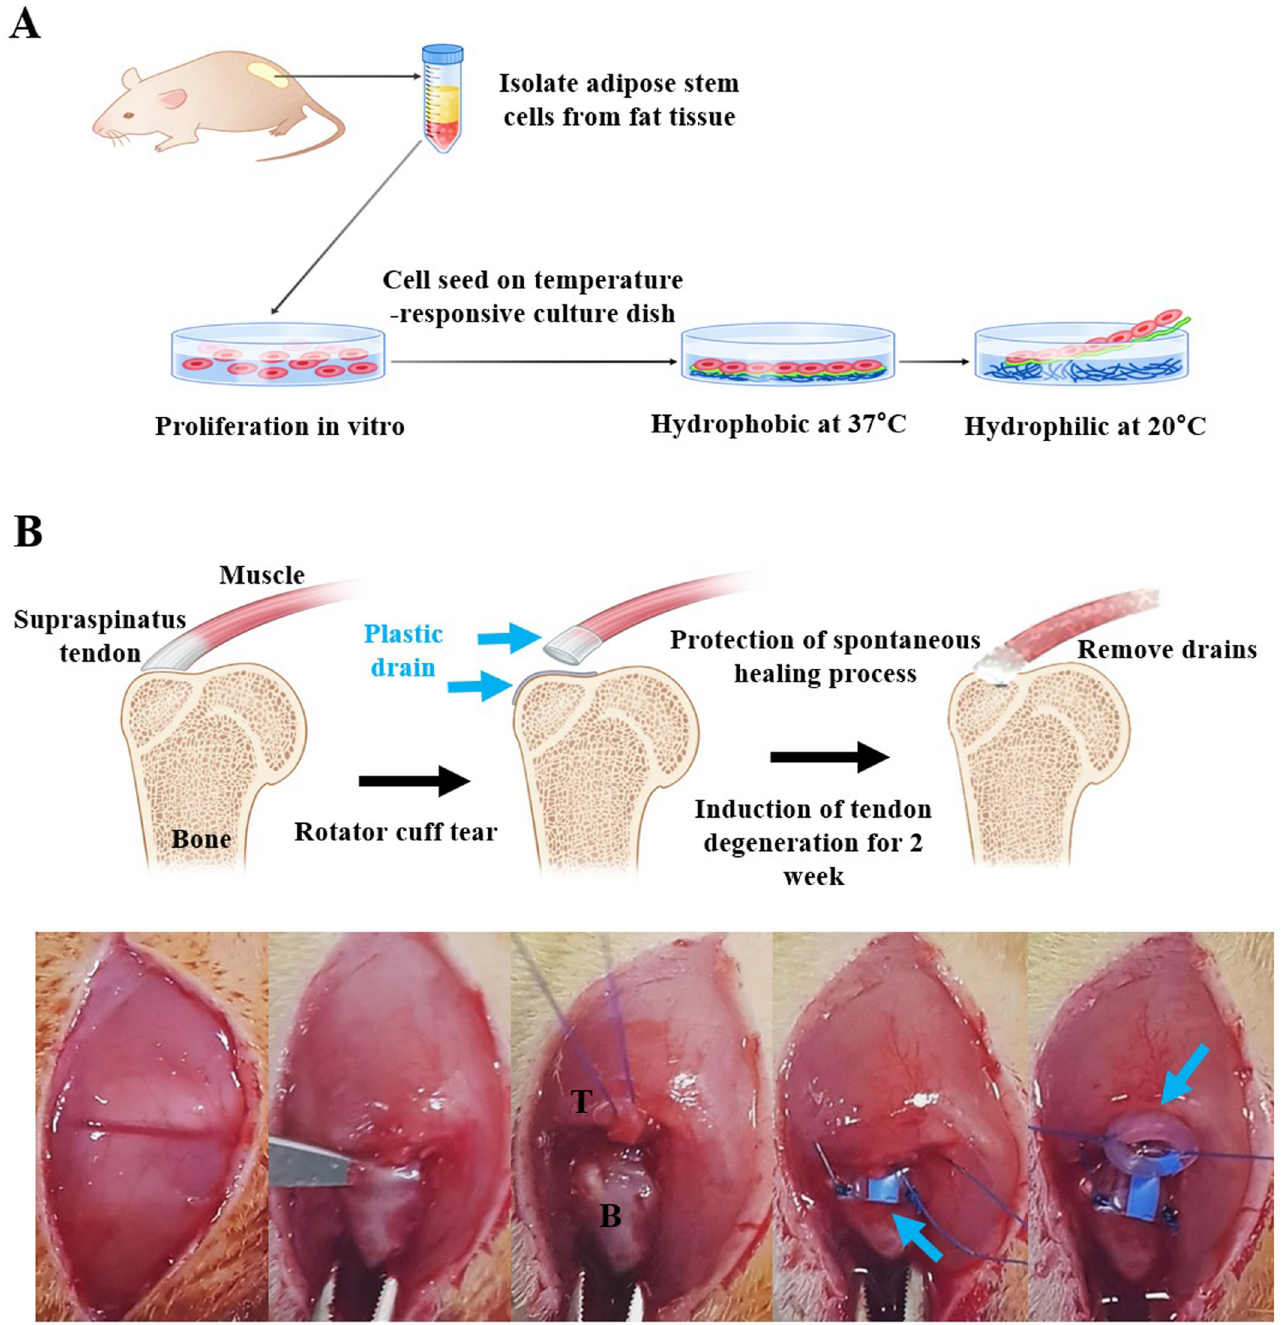
Fig 1. Schematic illustrations of the cell sheets for enhancing regeneration after rotator cuff tear repair. (A) The concept of producing a cell sheet using adipose-derived stem cells isolated from rats. The sheets were harvested by changing the hydrophilicity of the dish surface and decreasing the temperature. (B) The process of creating a chronic rotator cuff tear model. The tendons were separated entirely and maintained for two weeks using a plastic drain in two places to block spontaneous healing. T: tendon, B: bone, Blue arrow: plastic drain.